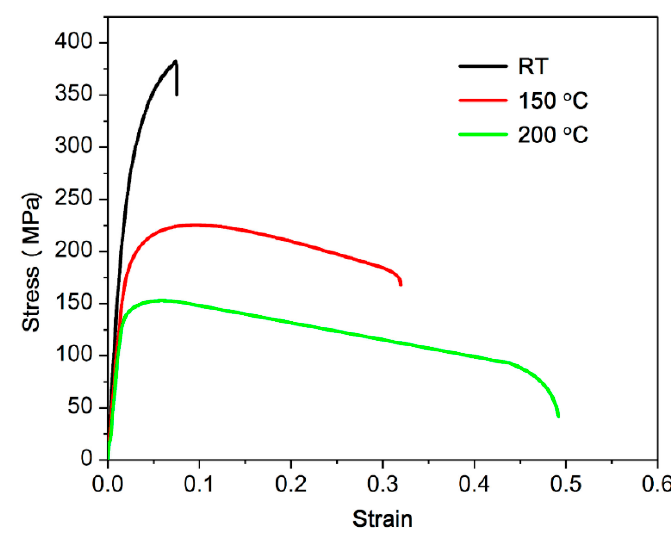
Figure 5. Engineering stress–strain curves of the as-extruded AZXSE91000 alloy at room temperature, 150 °C and 200 °C, respectively.